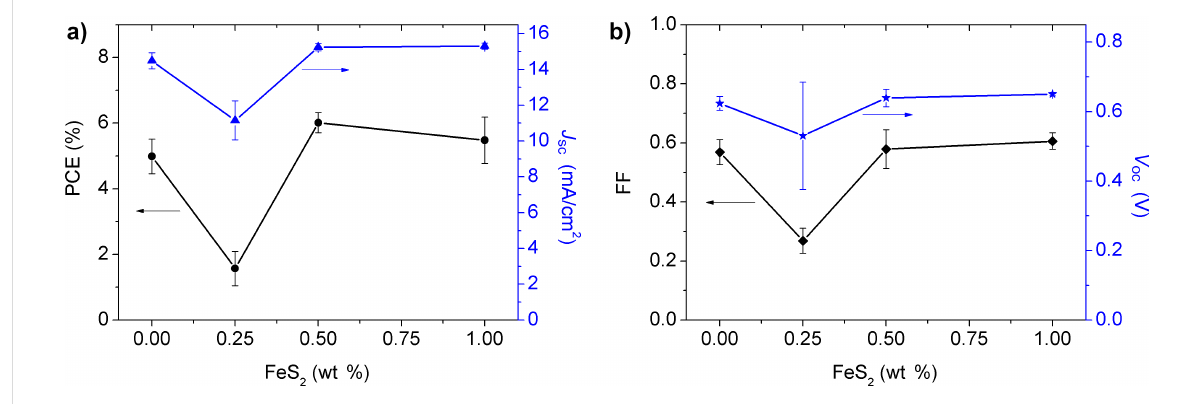
Figure 9: Electrical parameters of the OPVs as a function of FeS 2 NC content: a) PCE (black curve), J sc (blue plot); b) FF (black curve), V oc (blue plot). Three different sets and at least three devices for each concentration were tested.